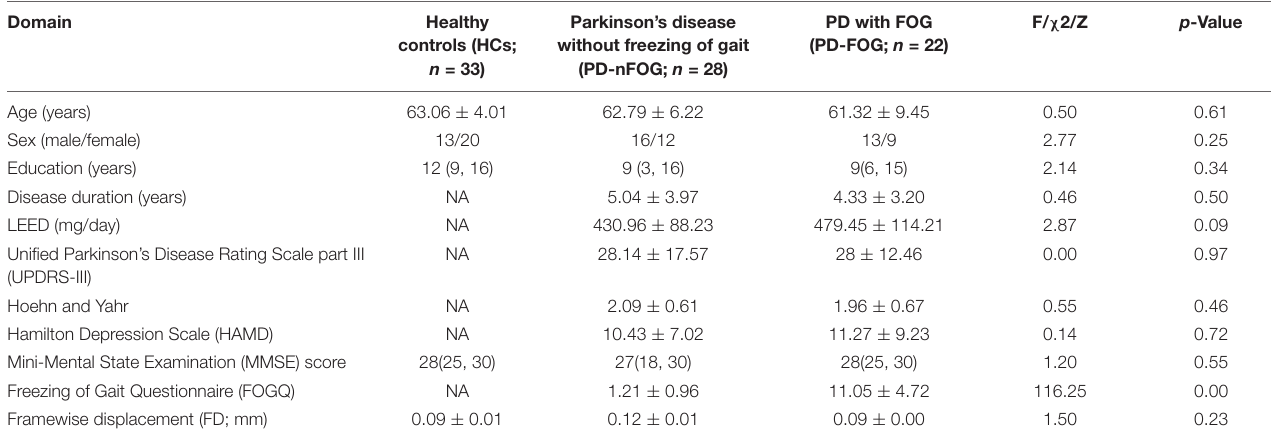
TABLE 1 | Demographic and clinical characteristics of all